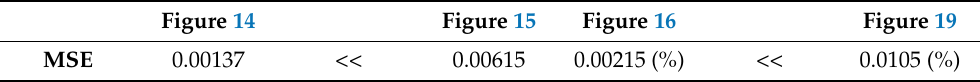
Table 3. The MSE values between the presented responses of the separation